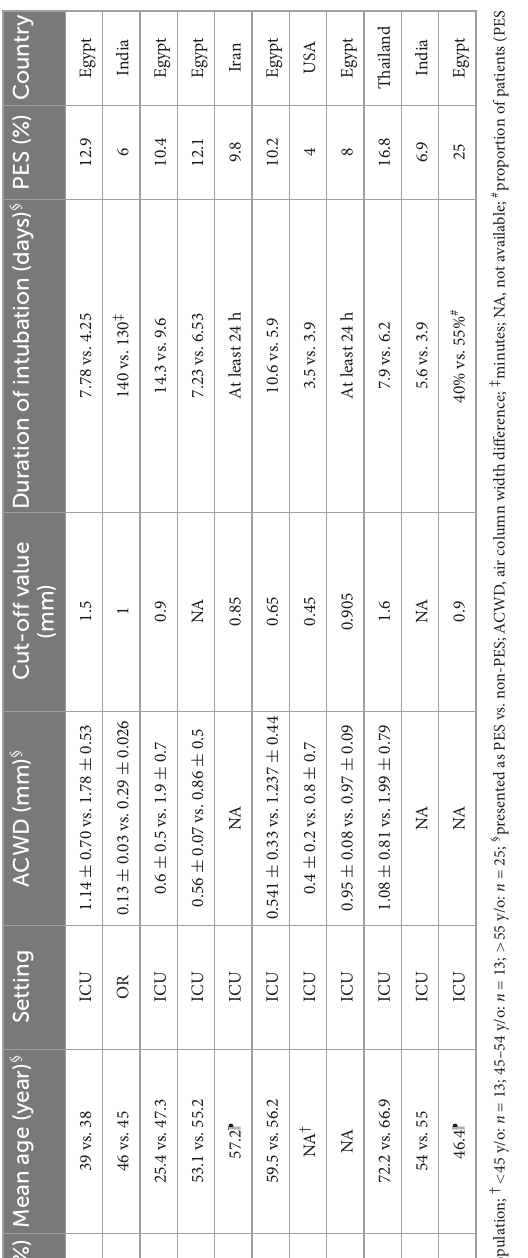
and specificity as well as the positive and negative likelihood ratios [LR (+) and LR ( − )], which were acquired with the formulas: LR (+) = sensitivity/(1 − specificity); LR ( − ) = (1 − sensitivity)/specificity. While statistical heterogeneity was investigated using Cochran Q-statistics, heterogeneity between studies was evaluated with the random effects model using the I 2 statistics. The diagnostic performance of sonography was assessed with AUC from constructed summary ROC (sROC) curves (16). Based on LR (+) and LR ( − ), post-test probability was estimated with a Fagan’s nomogram. The potential publication bias was examined by inspecting Deek’s funnel plot. A p < 0.05 was regarded as statistically significant. Forest plots of pooled estimates of sensitivity and specificity, Deek’s funnel plot, sROC curve, and Fangan’s nomogram plot were constructed with the meta-analytical integration of diagnostic test accuracy studies (MIDAS) command in Stata 15 (StataCorp LLC., College Station, TX, USA) as previously reported